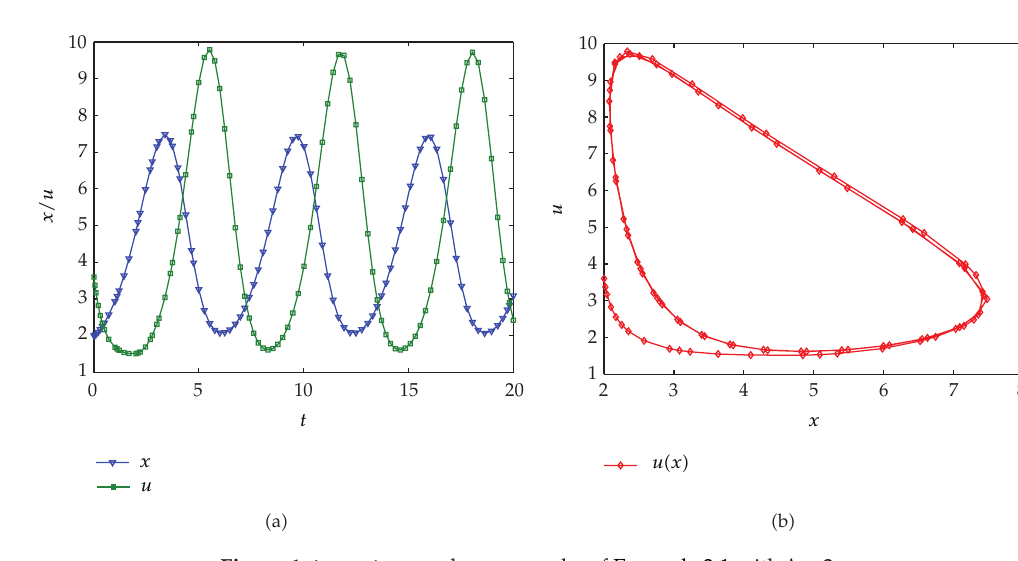
Figure 1: t − x, t − u and x − u graphs of Example 3.1 with λ (cid:8)